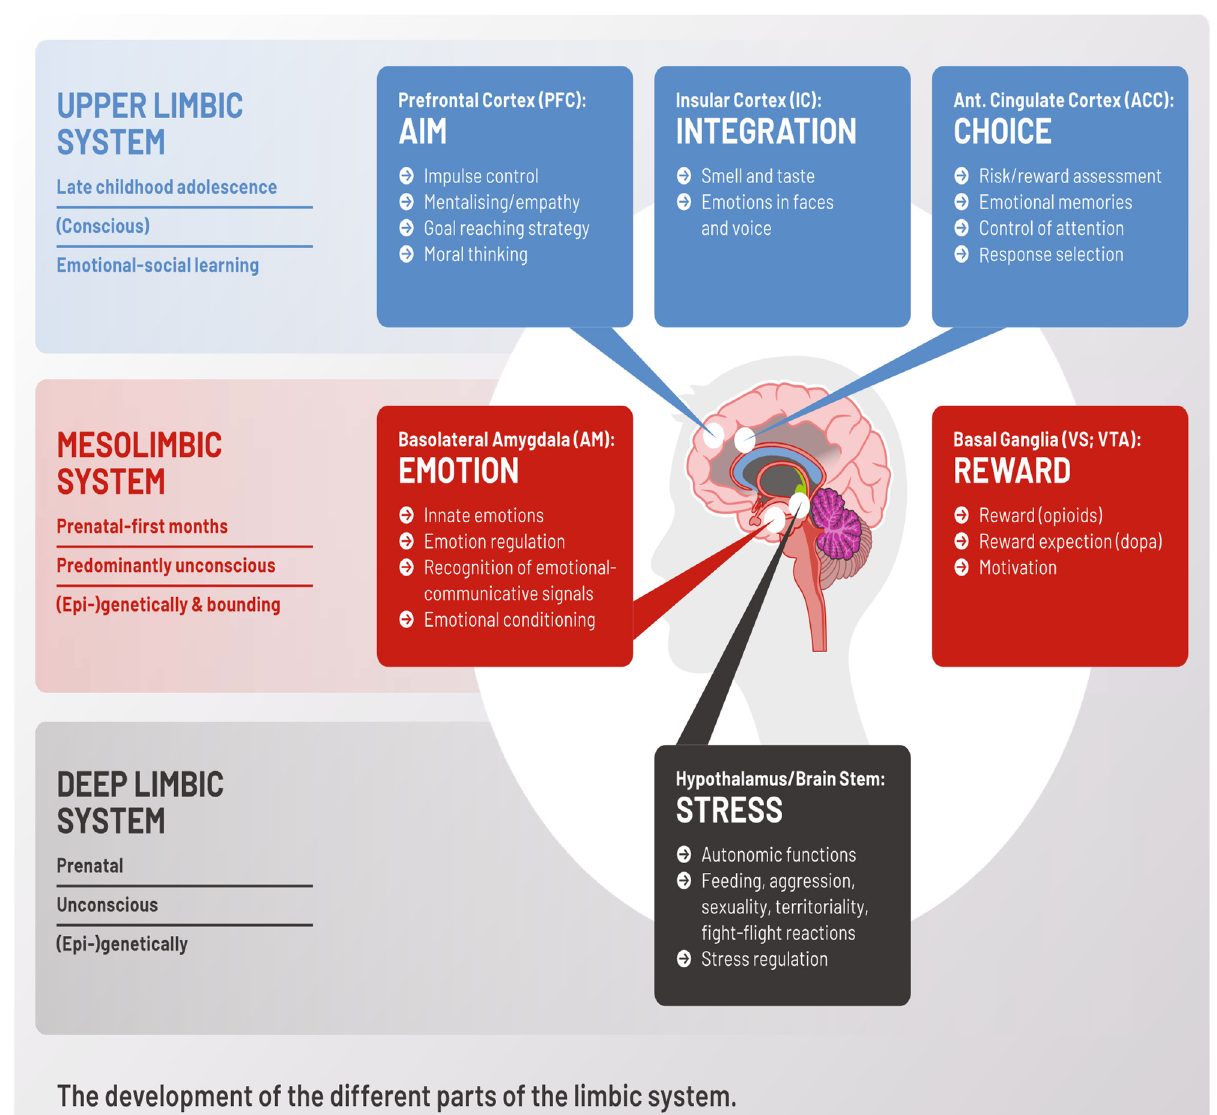
Figure 2. The development of the different parts of socio-emotional brain networks. Details about the different parts and functions of the limbic system c.f. [33]. Socio-emotional brain functions rely on a proper formation of the respective brain areas of the limbic system. Depending on the severity of brain damage, also socio-emotional competencies are affected accordingly. Abbreviations: PFC: Prefrontal Cortex; IC: Insular Cortex; Ant.: Anterior; ACC: Anterior Cingulate Cortex; Bl.: Basolateral; AM: Amygdala; Basal Gang.: Basal Ganglia; VS: Ventral Striatum; VTA: Ventral Tegmental Area.